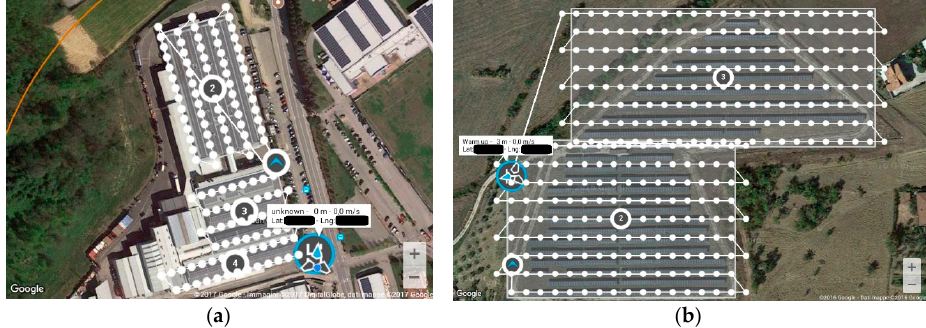
Figure 1. The flight plans designed using the SkyDirector app, for the aerial data acquisition. ( a ) and ( b ) depict the flight plans used for Plant A and Plant B, respectively.